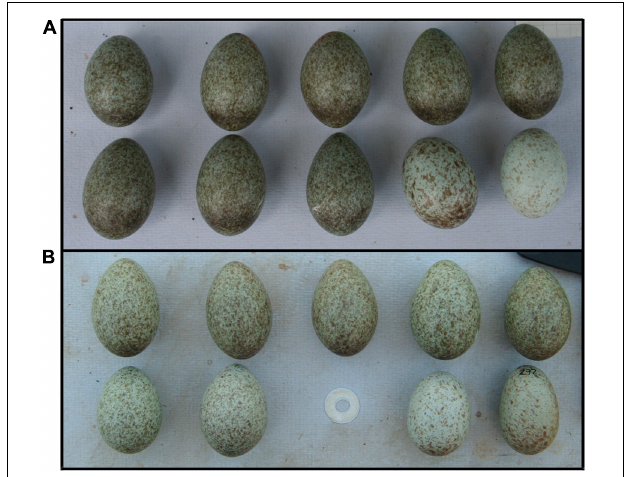
FIGURE 1 | Magpie clutches parasitized by Great spotted cuckoo. The picture shows magpie eggs, real cuckoo egg, and experimental model eggs. (A) Eight magpie eggs, one great spotted cuckoo egg and mimetic model egg in the lower right corner. (B) Seven magpie eggs, one great spotted cuckoo egg near to mimetic model egg in the lower right